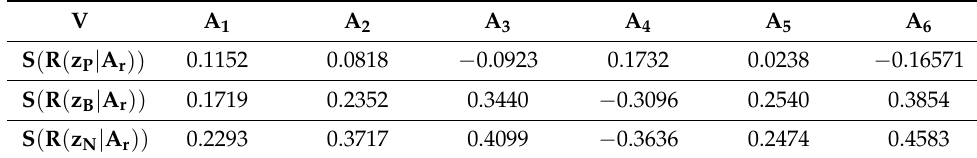
Table 9. The score function of expected losses of GRA